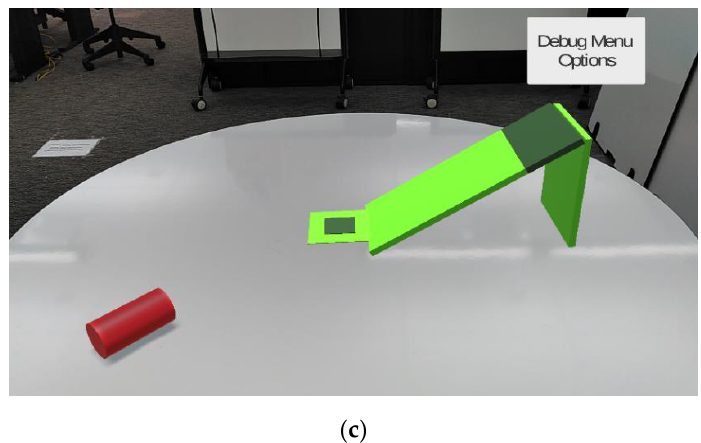
Figure 3. Small-scale tests. ( a ) Test 1: 2D translation; ( b ) Test 2: 3D translation; ( c ) Test 3: 3D translation and rotation.